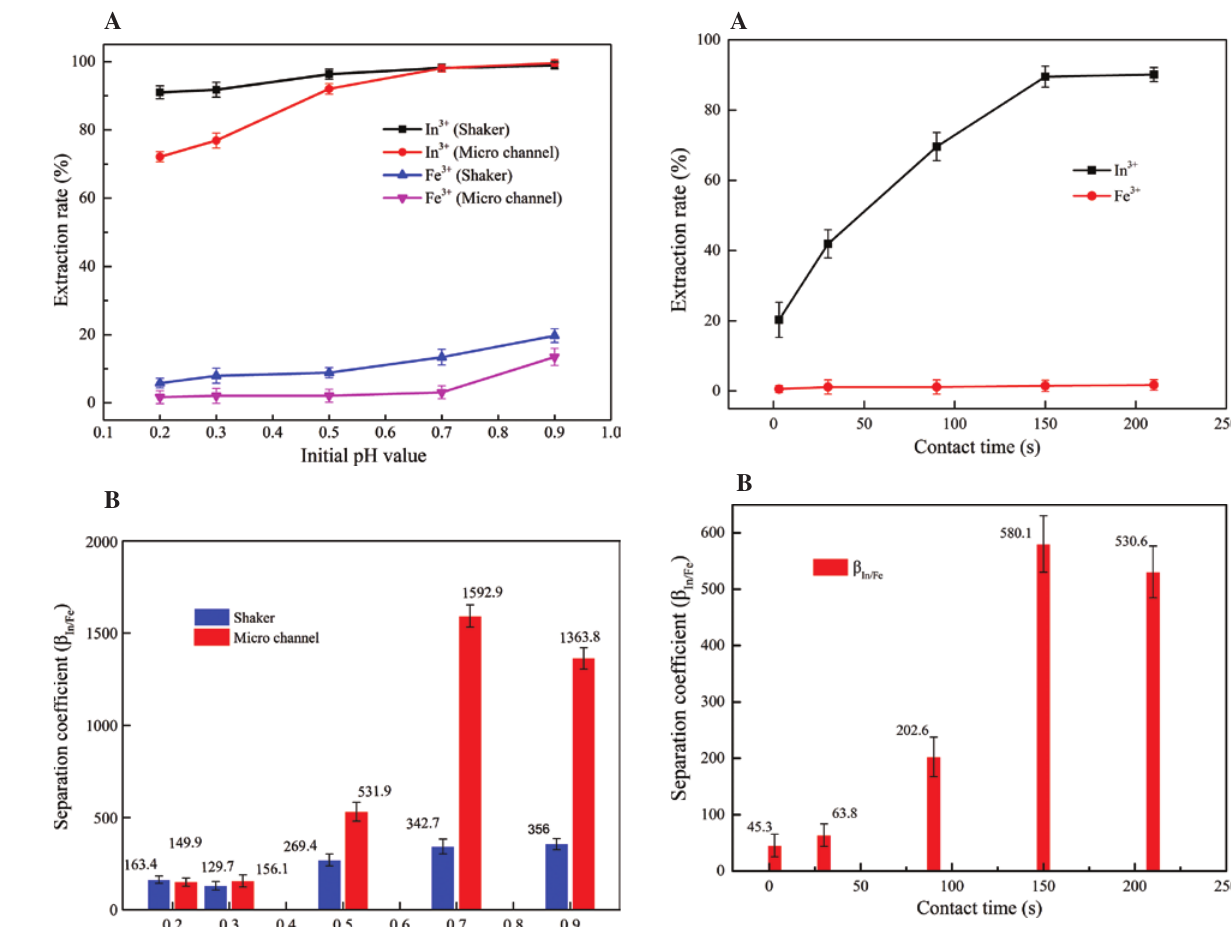
Figure 5: Effect of contact time: (A) effect of initial contact time on the extraction efficiency, (B) effect of contact time on the separation coefficient. Aqueous phase: [In 3 + ] = 2.59 g l − 1 , pH = 0.5, [Fe 3 + ] = 2.12 g l − 1 ; = 30%; O/A = 1:1, Q = 7.2–504 μ l/min, T = 298 K. organic phase: ϕ D2EHPA = 30%; D2EHPA